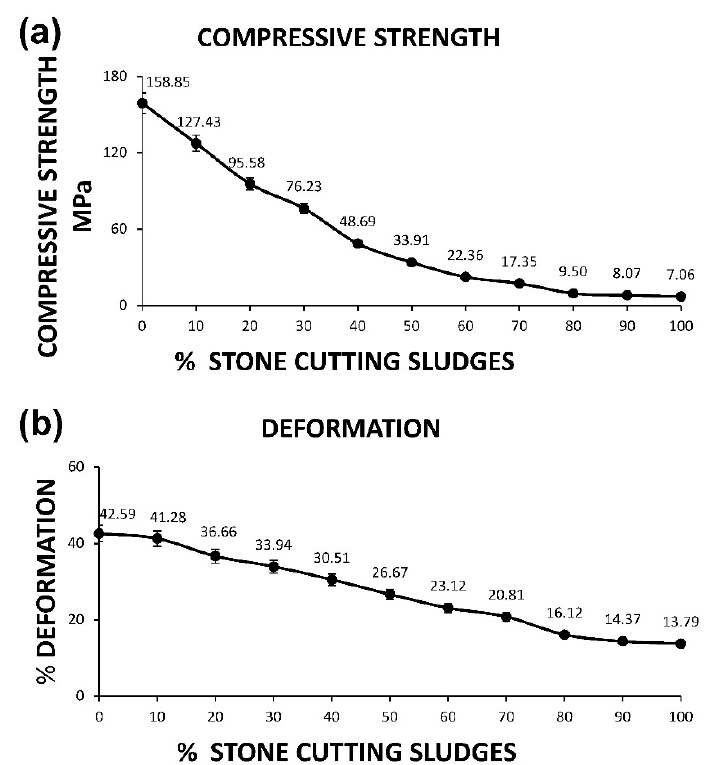
Figure 5. Graphs of the compressive strength test of the different groups of ceramic samples as a function of the percentage of stone cutting sludges. ( a ) Compressive strength and ( b ) deformation before material collapse.